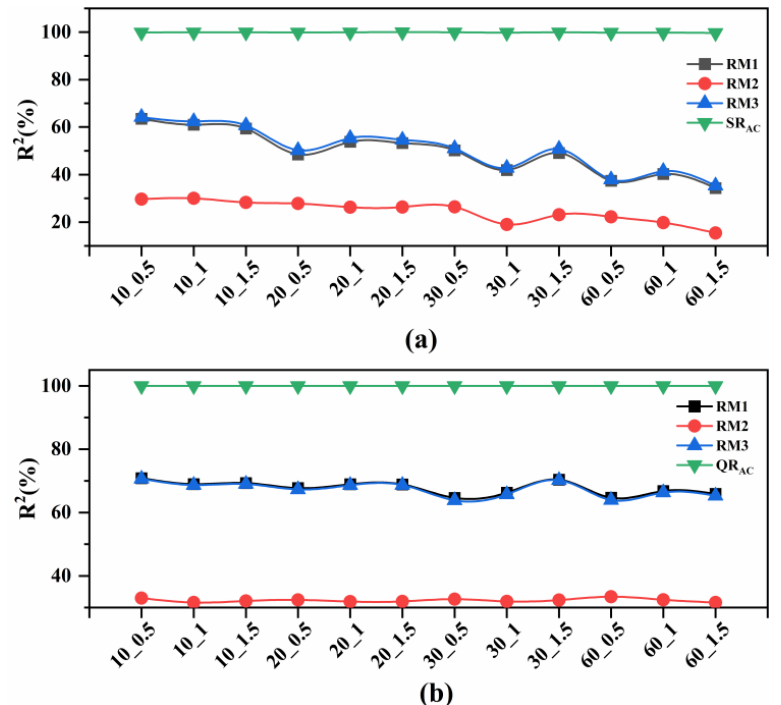
Figure 8. Comparison of 𝑅 2 values at different fault levels. ( a ) Compare of 𝑅 2 values in solution robustness. ( b ) Compare of 𝑅 2 values in quality robustness.